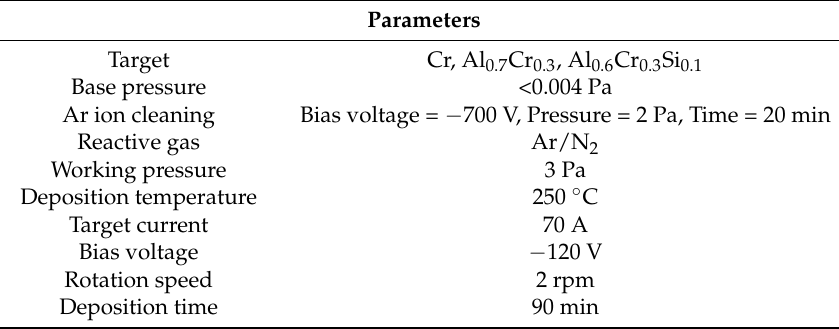
Table 2. Parameters for AlCrSiN thin-film